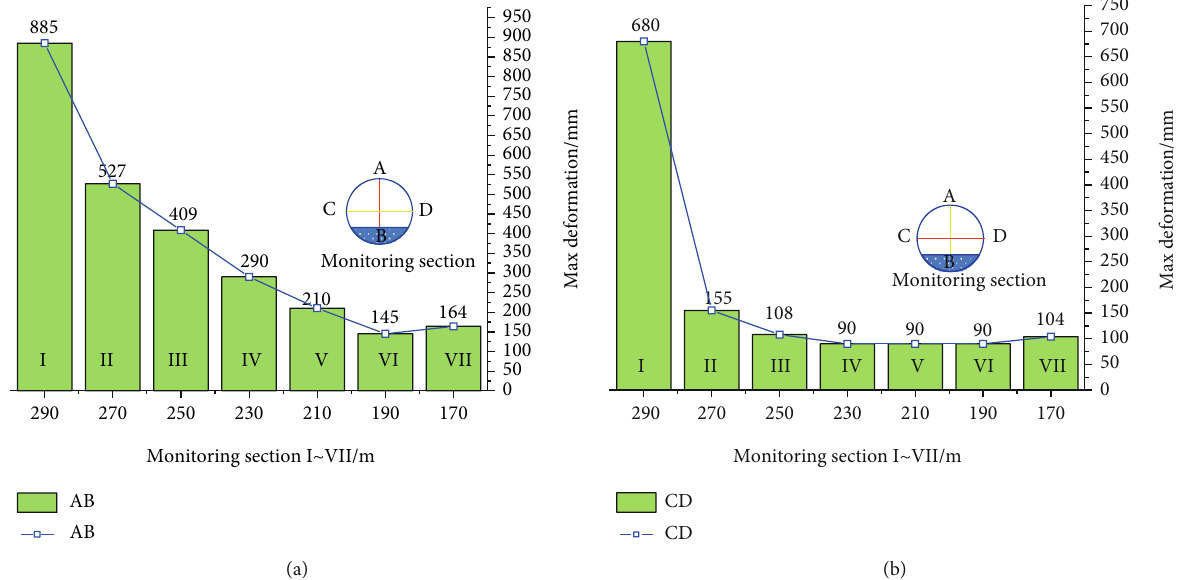
Figure 14: Statistics of the maximum deformation of the test section. (a) Displacement between the roof and fl oor. (b) Displacement of the two sides of the roadway.